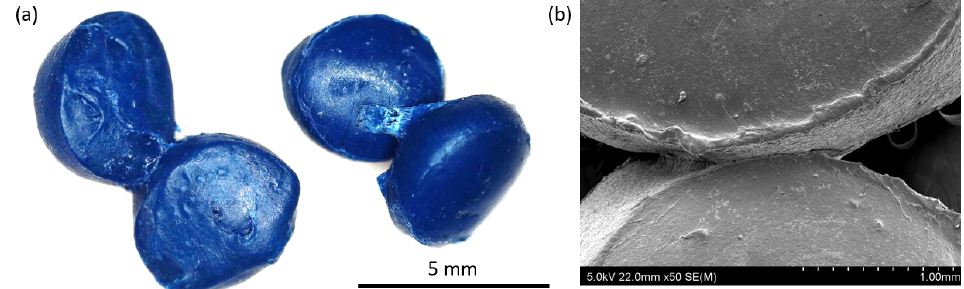
Figure 6. PP granules after compression testing for 250 cycles ( a ). SEM micrograph of adhered granules ( b